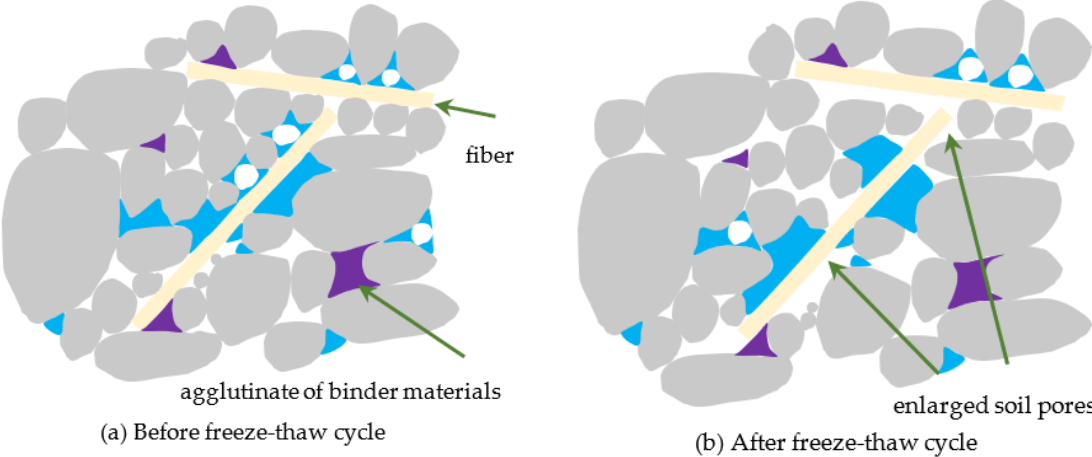
Figure 9. Interfacial mechanical interaction sketch of RSF.